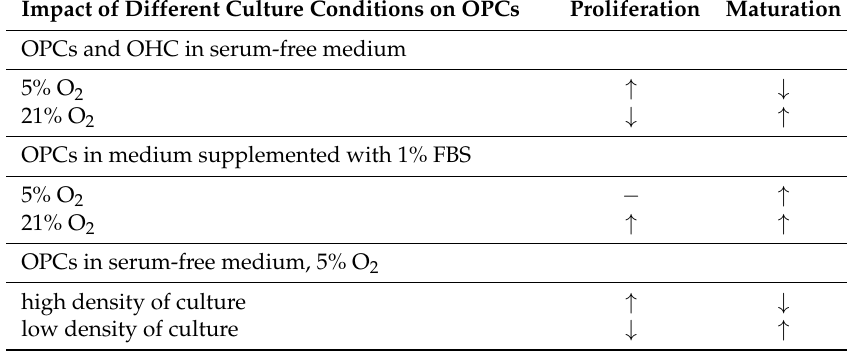
Table 1. Impact of the culture conditions on OPCs proliferation and differentiation into mature cells capable of myelinogenesis. Impact of Different Culture Conditions on OPCs